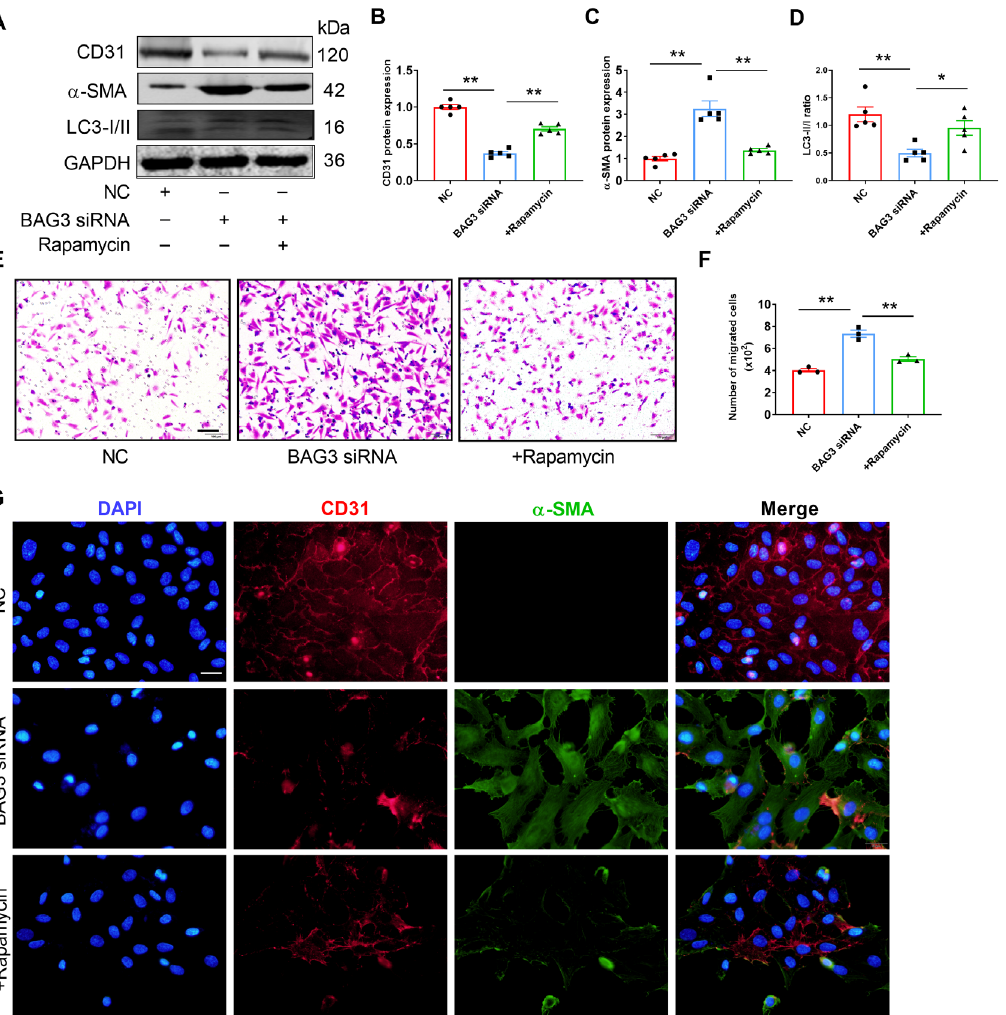
Figure 5. BAG3 suppresses EndMT by inducing autophagy in HUVECs. ( A – D ) CD31 and α -SMA protein expressions and the LC3-II/LC3-I ratio were detected using Western blotting. Fold changes are shown ( n = 5). ( E , F ) Transwell cell invasion assay was performed to analyze the migration ability of cells (scale bar indicates 100 µm) ( n = 3). ( G ) Representative images of double-fluorescent staining with α -SMA (green) and CD31 (red). The nuclei were stained blue with DAPI. (scale bar indicates 50 µm) ( n = 3). The data are presented as the mean ± S.E.M. * p < 0.05, ** p < 0.01.